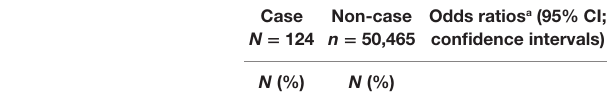
TaBle 3 | characteristics of longest childhood residence and associations with sle.